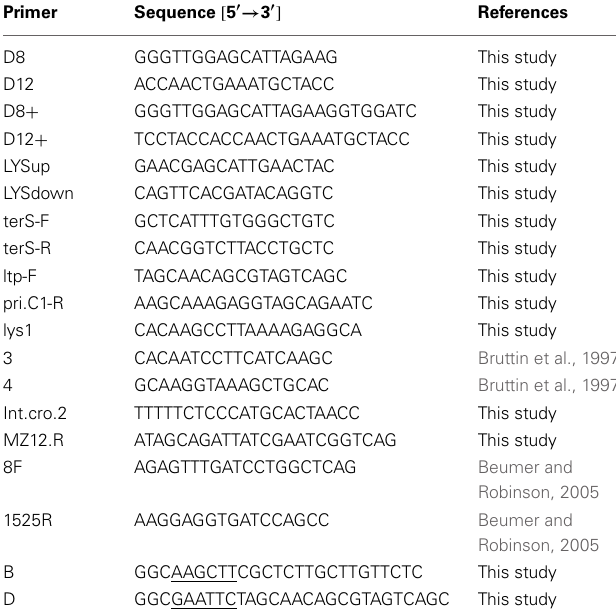
Table 1 | PCR-primers used for amplification of genomic